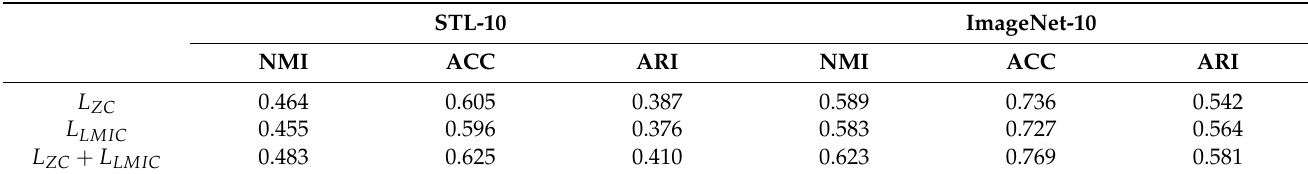
Table 5. The sensitivity of the model to mutual information.